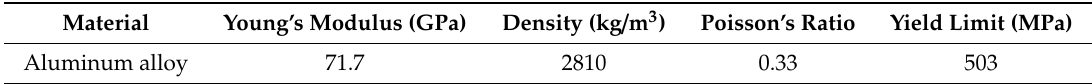
Table 2. Material properties of the microgripper.